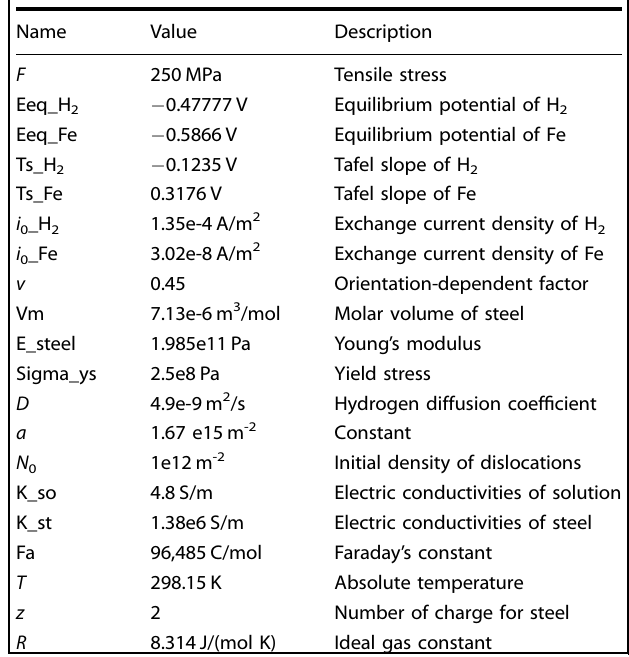
Table 2. The main parameters used in the calculation of the functions.